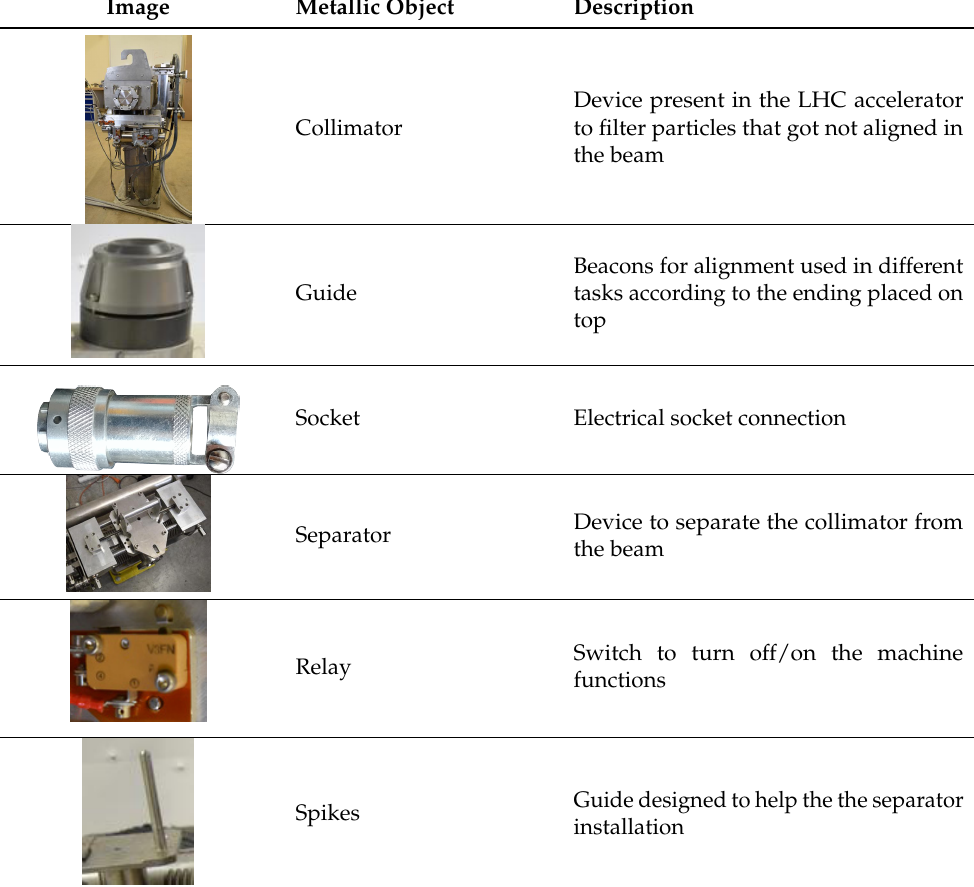
Table 4. Summary of the Data-set used to train the metallic targets object recognition